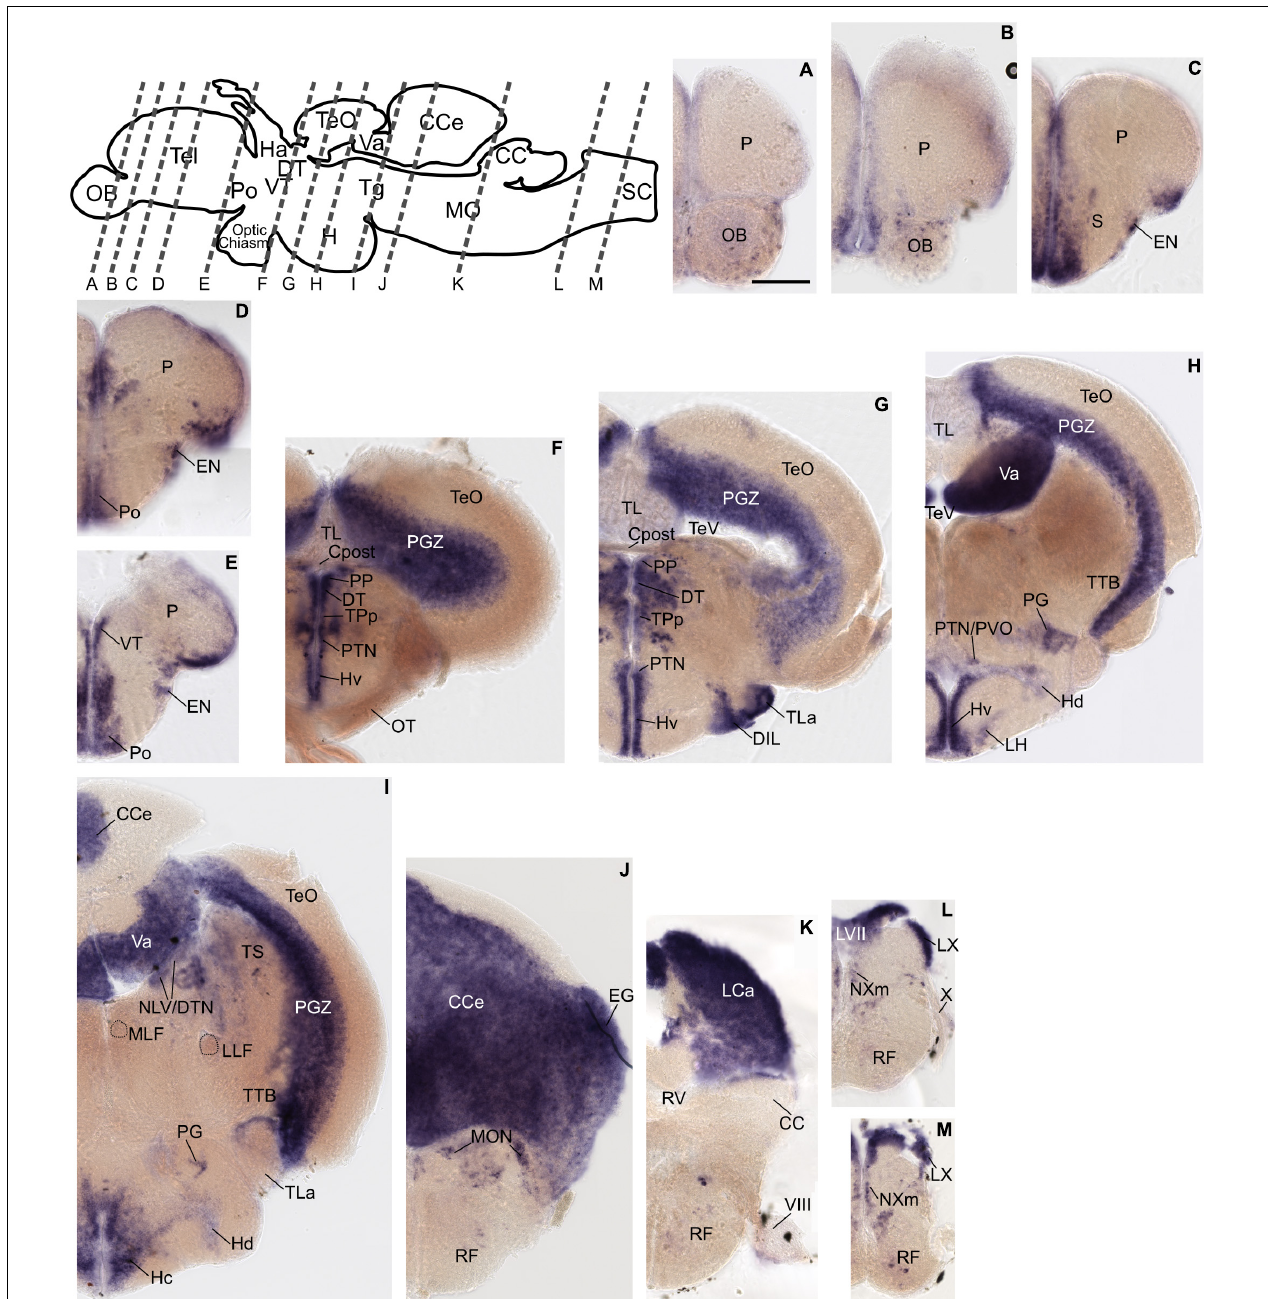
FIGURE 2 | Grm8a expression pattern in adult zebrafish brain labeled by RNA in situ hybridization. (A–M) Grm8a transcript labeling by RNA in situ hybridization on cross-sections of an adult zebrafish brain. Images are arranged from anterior to posterior as indicated by the scheme at the top. Details on grm8a expression pattern are described in the main text. Anatomical abbreviations are listed in Table 1 . Scale bar is 200 µ